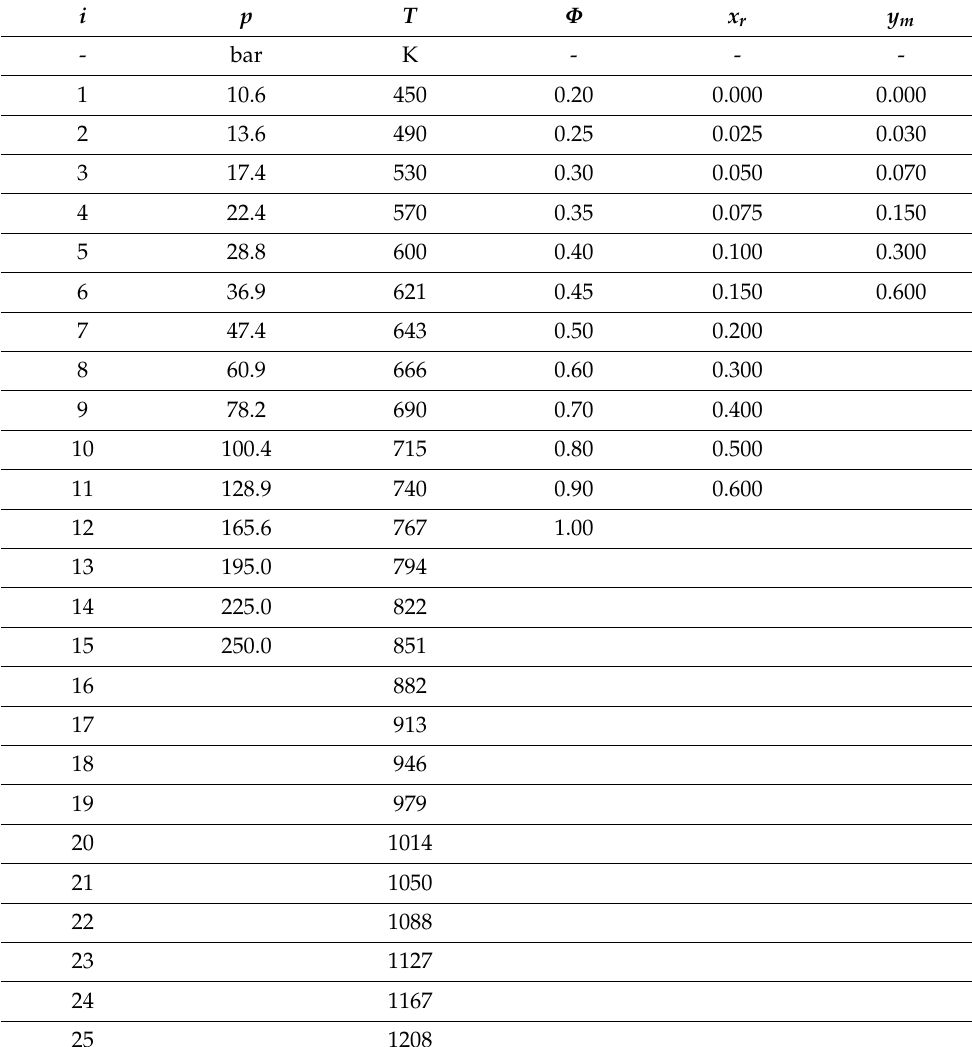
Table 4. Initial conditions for tabulation